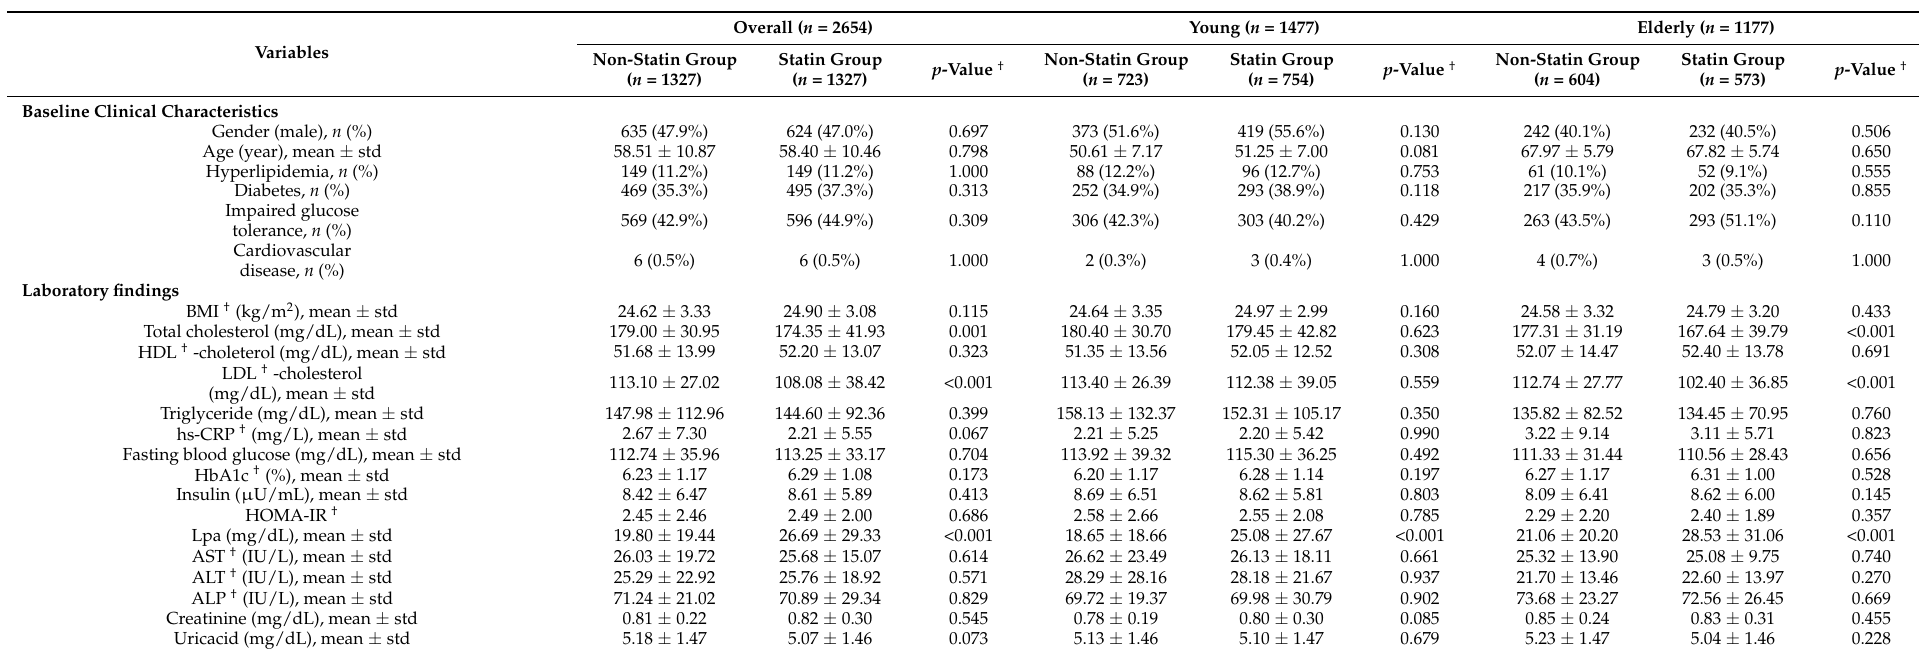
Table 3. Baselines of study patients stratified by young and elderly groups after propensity score matching.